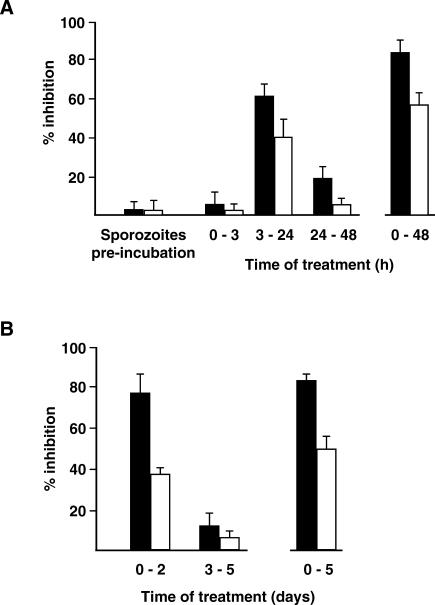
Susceptibility of Plasmodium Hepatic Stages to Tazopsine during GrowthIt should be noted that the in vivo duration of the hepatic phase of P. yoelii is 44 to 48 h, whereas that of P. falciparum is just under 6 d.(A) P. yoelii cultures were subjected to 3 μM (IC50; open bars) or 5 μM (IC80; filled bars) of tazopsine for different periods of the development. Preincubation of 80,000 sporozoites (Spz) in the presence of 5 μM or 100 μM of tazopsine for 1 h or 3 h, respectively, were carried out at room temperature prior to washing and being added to the mouse primary hepatocyte well.(B) P. falciparum cultures were subjected to 4 μM (IC50; open bars) or 10 μM (IC80; filled bars) of tazopsine for different periods of development. Inhibition was measured as the number of parasite forms in test wells divided by the number of parasites in control wells, for P. yoelii, the average number in control wells equaled 408, and for P. falciparum, 105. Results are means ± standard deviation.